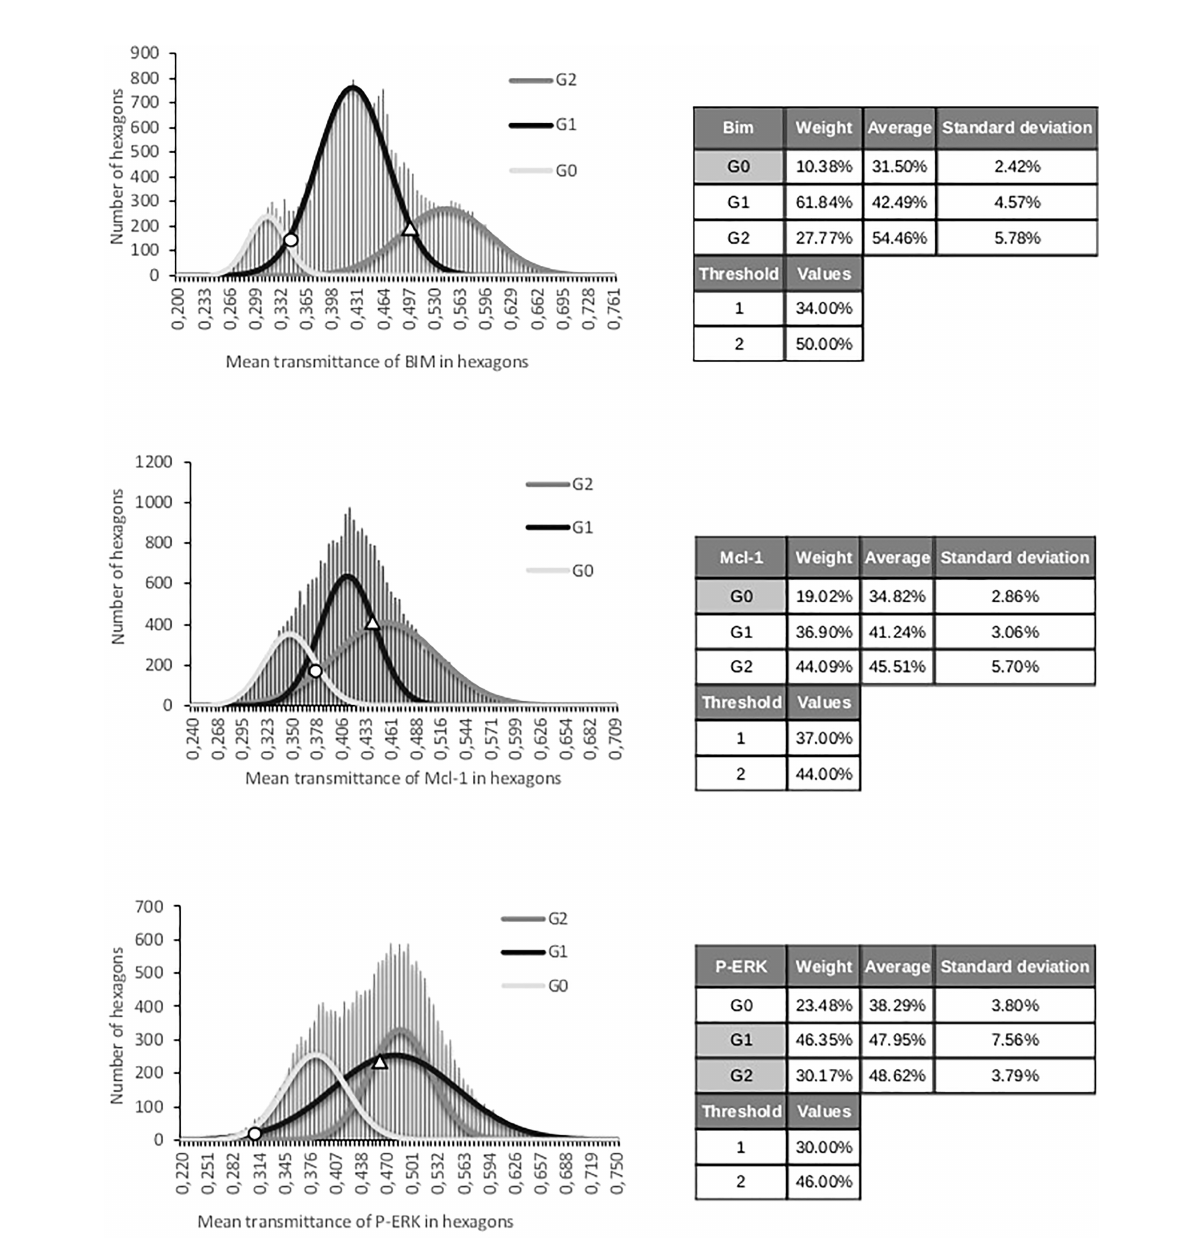
FIGURE 4 Distribution of mean transmittance of all hexagons for each marker (Bim, Mcl-1, and P-ERK). Parameters for three Gaussian functions and two thresholds for each set of hexagonal patterns (Bim, Mcl-1, and P-ERK). Circle and triangle indicate threshold